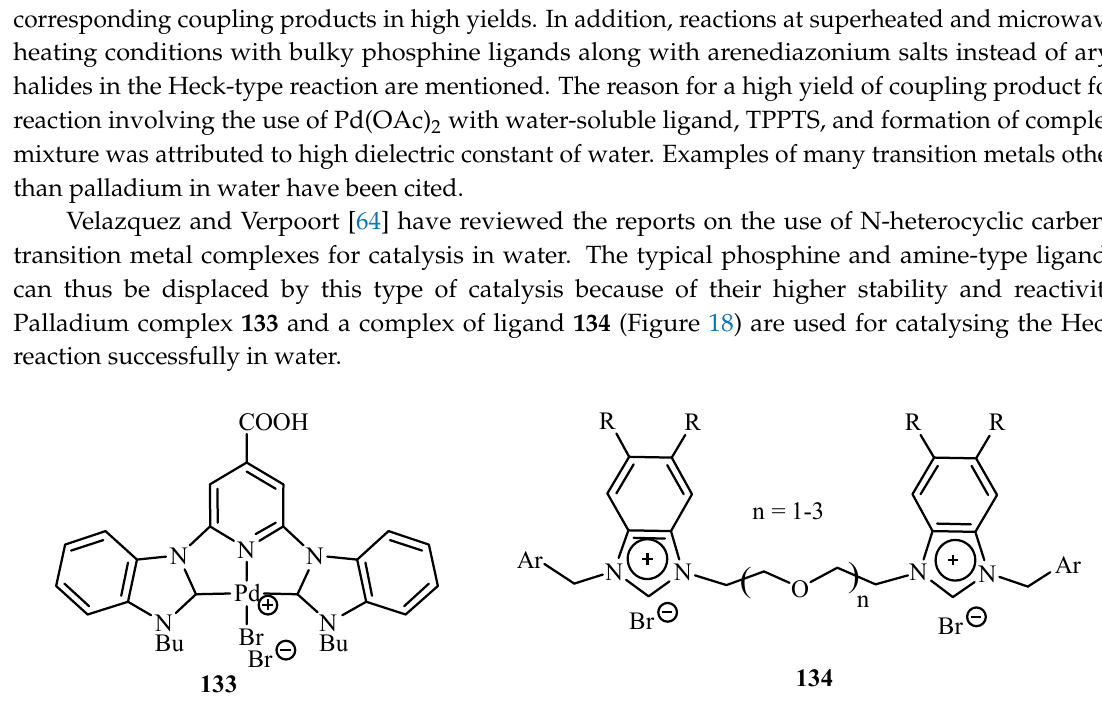
Figure 18. N-heterocyclic carbene ligand and transition metal complex for catalysis in water reviewed by Velazquez and Verpoort [64].